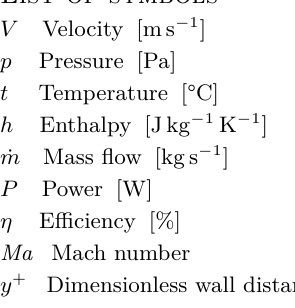
Figure 15. CFD results with the new outlet casing